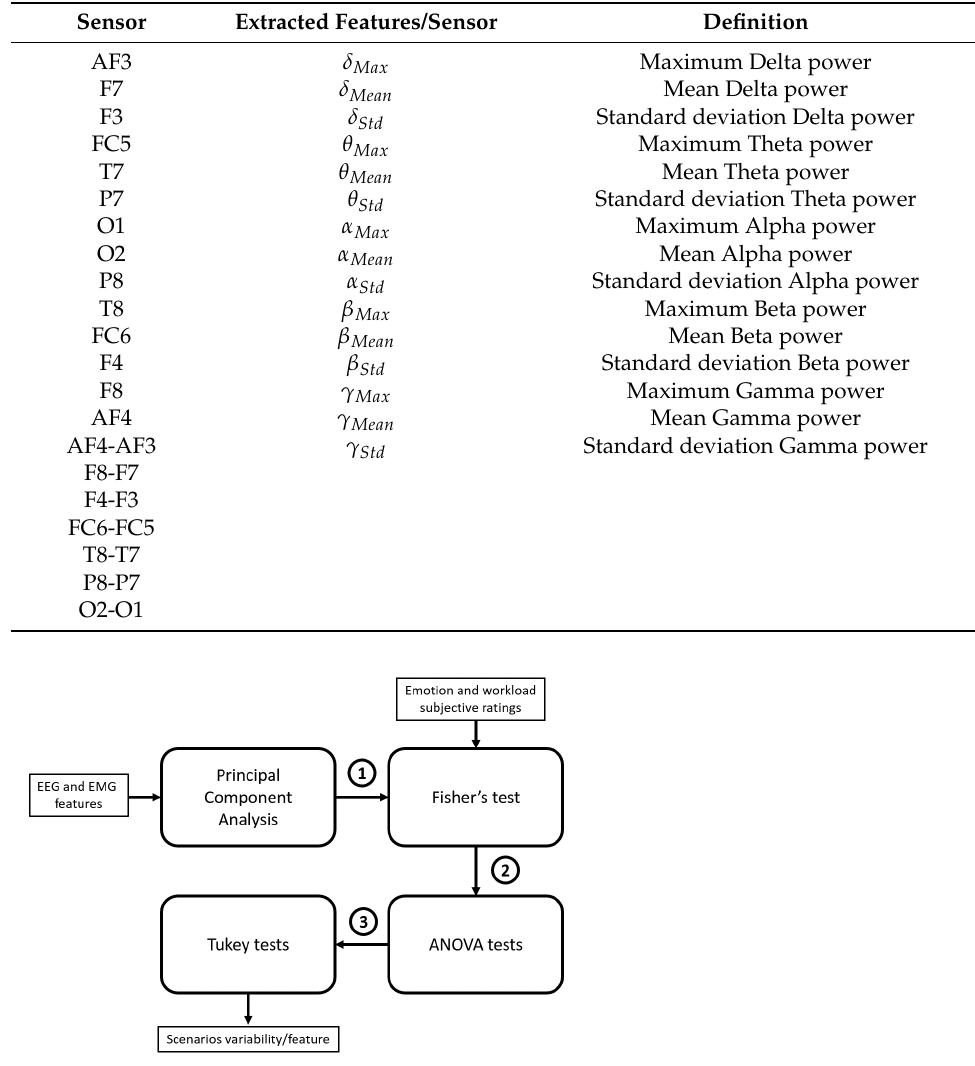
Table 2. Features extracted from EEG.